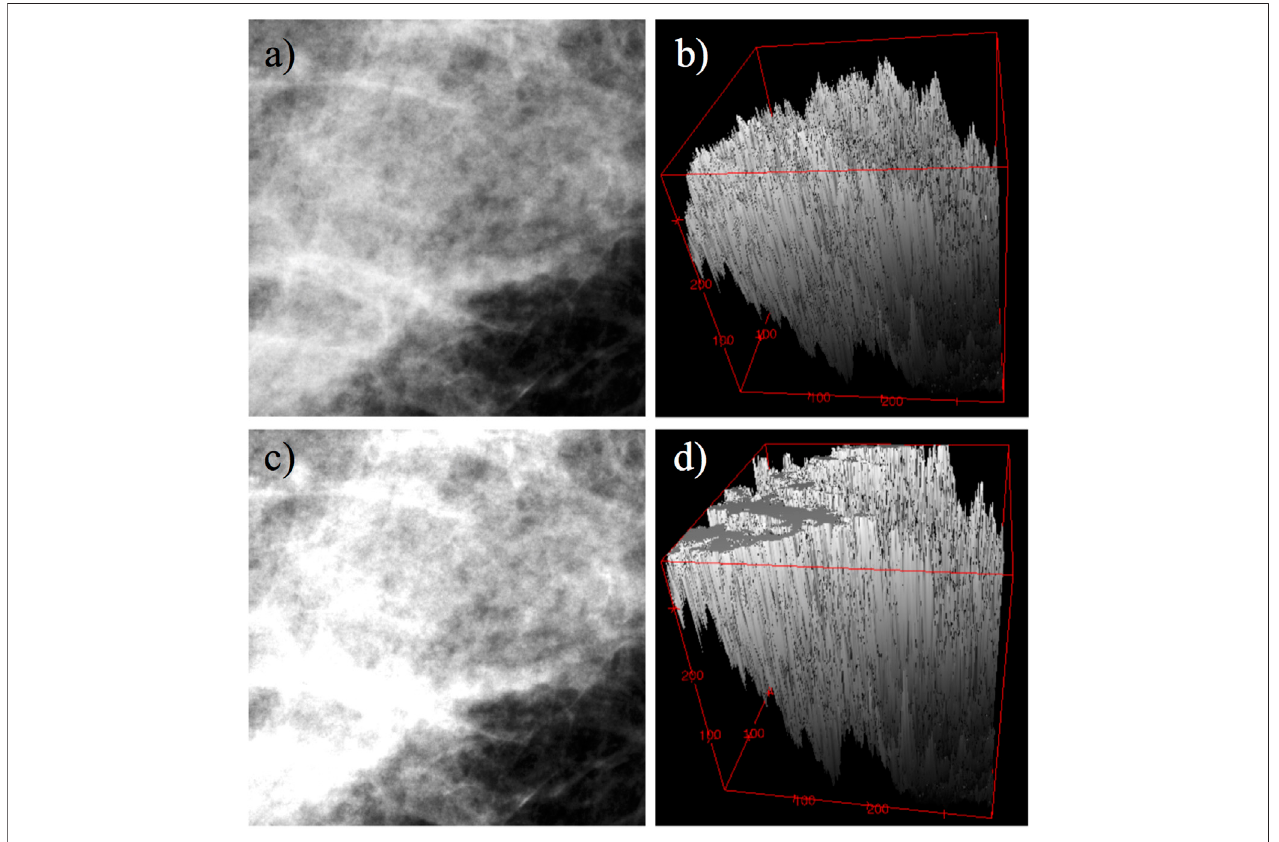
FIGURE 1 | Example of saturation effects on a 360, ×, 360 pixel subregion from a mammogram. (A) Original image. (B) Mesh representation of image (A) as a rough surface. (C) Same image as in (A) , but saturated at 20%. (D) Mesh representation of image (C) as a rough surface.